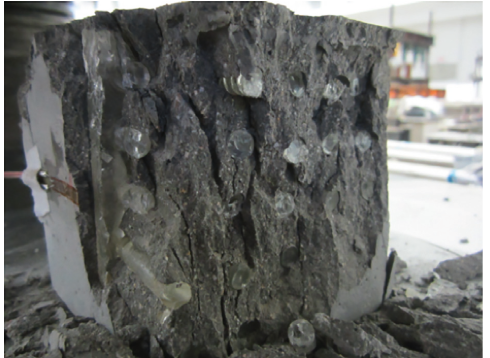
Figure 21: Destructive form of RTMC.